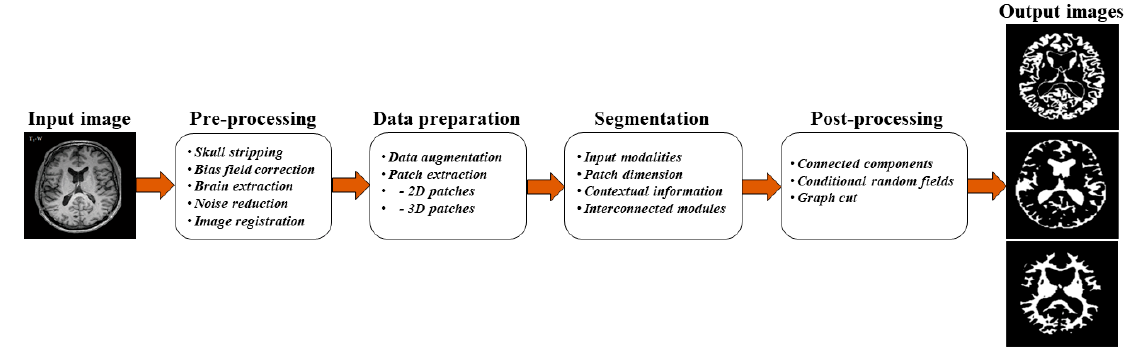
Figure 2. General pipeline for brain MRI analysis.